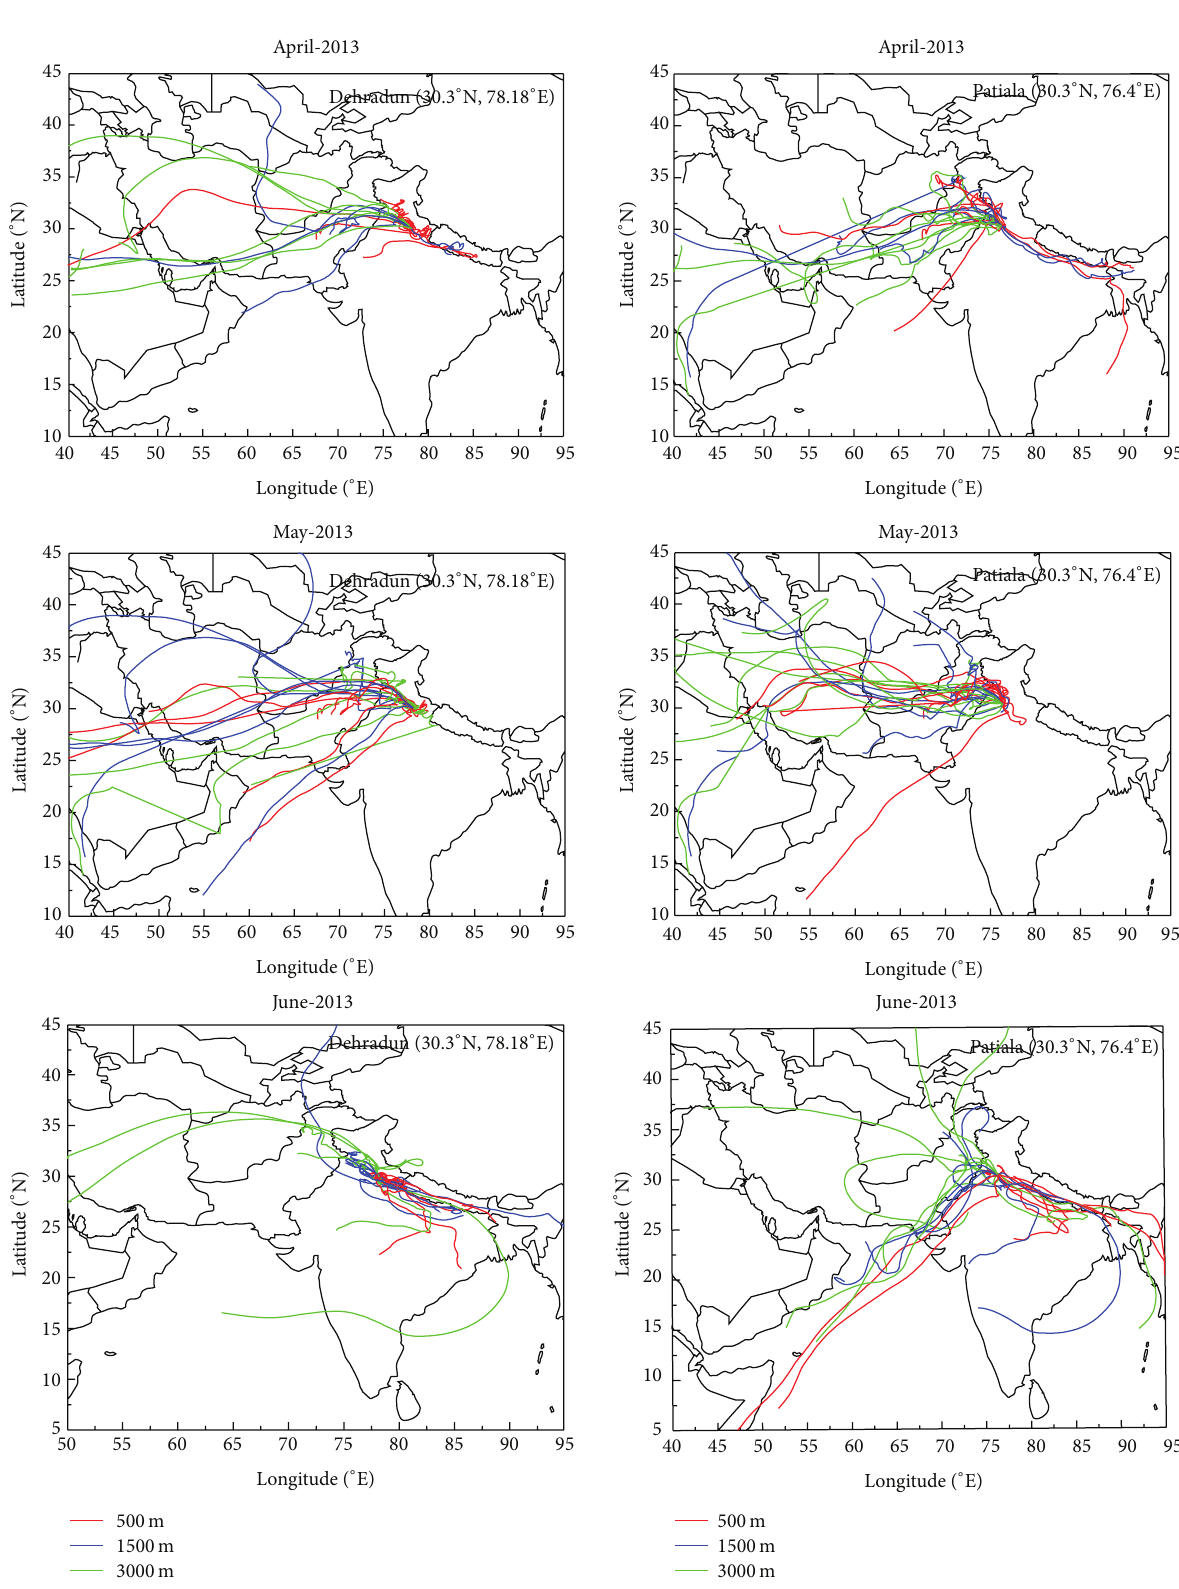
Figure 7: Air mass back trajectory at Dehradun and Patiala stations at three different altitudes during April–June